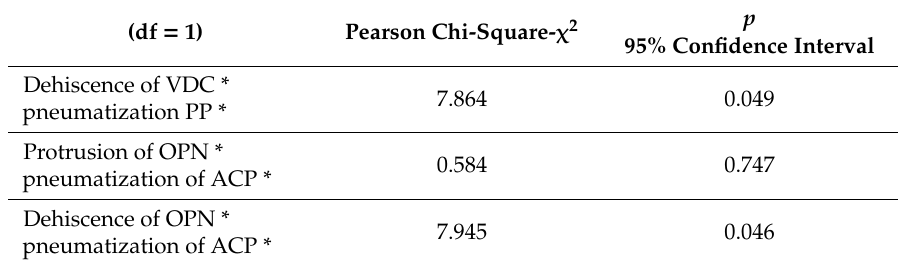
Figure 6. Dehiscence and protrusion of sphenoid sinus in relationship to internal carotid artery (ICA) and optic nerve. Axial CT image ( A ) showing dehiscence and protrusion of right ICA, ( B ) showing dehiscence of optic nerve (R) and protrusion of optic nerve (L). Note the differential protrusion and dehiscence in Ethiopian population. Image orientation: S, superior; I, inferior; R, right side; L, left side. Table 4. Chi-square Tests.